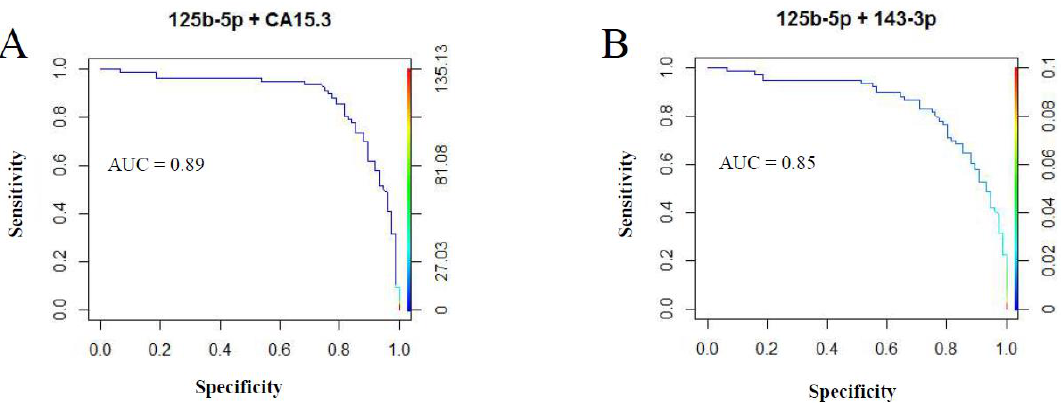
Figure 7. ROC curve analyses and AUC values combining the profiles of miR-125b-5p and CA15-3 ( A ) and miR-125-5p and miR-143-3p ( B ) for discriminating BC patients from healthy patients. ROC: Receiver operating characteristic; AUC: area under the ROC curve; BC: breast